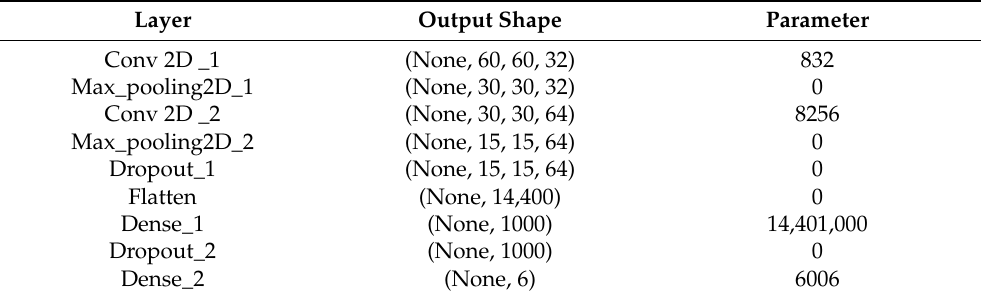
Table 11. Layers and numbers of parameters in the IMU and joint position input